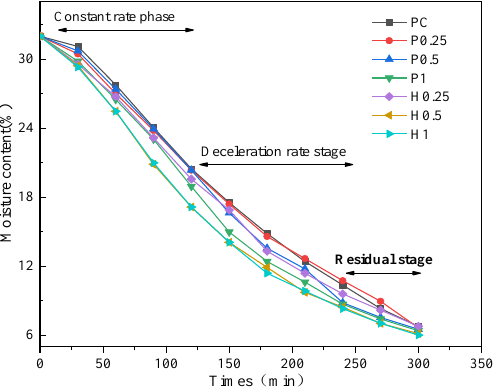
Figure 4. Decrease of the moisture content of the specimens with time elapsing.